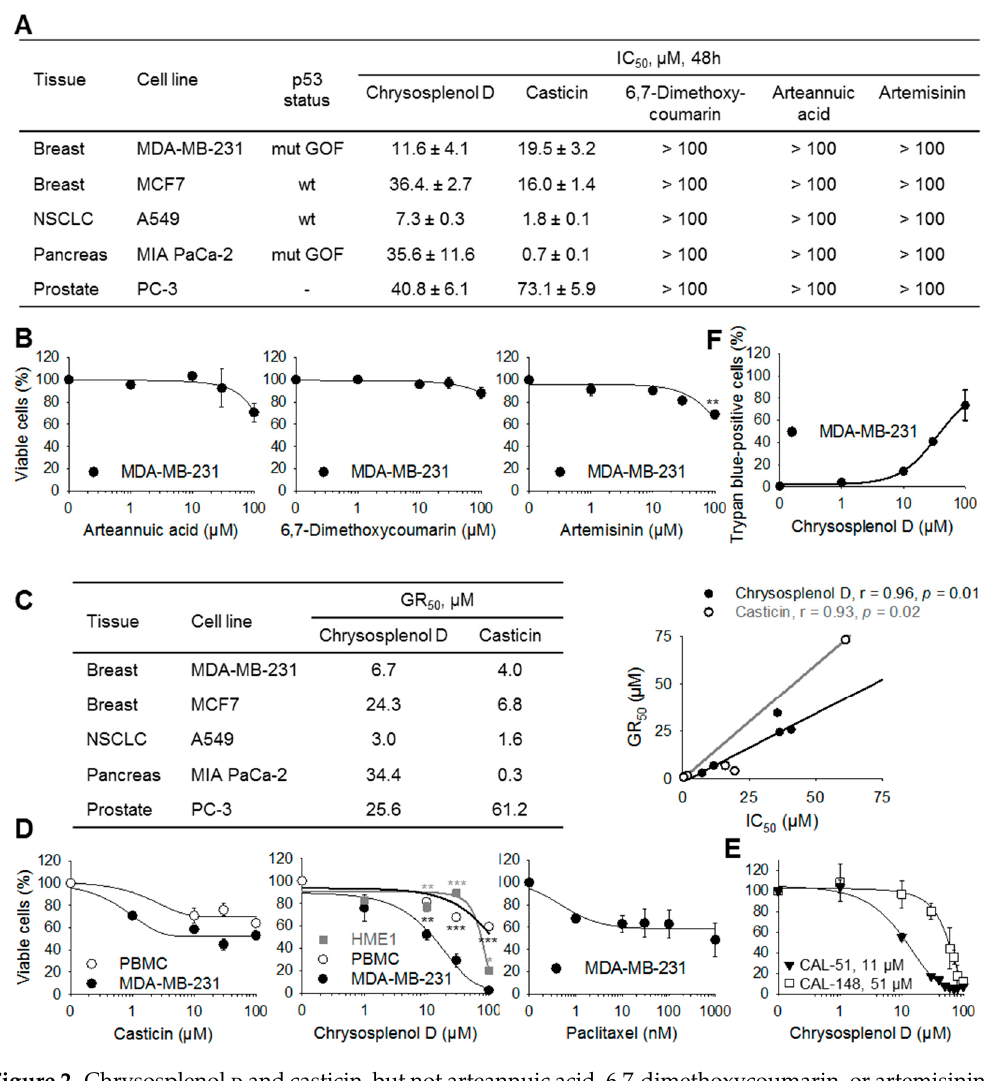
Figure 2. Chrysosplenol D and casticin, but not arteannuic acid, 6,7-dimethoxycoumarin, or artemisinin, inhibit selectively the viability of several cancer cell lines. Cells were treated with the various compounds for 48 h and analyzed by XTT ( A - E ). ( A ) NSCLC, non-small cell lung cancer; mut GOF, gain of function mutation. Apparent IC 50 values for casticin are shown. ( B ) Viability of MBA-MB-231 cells after treatment with arteannuic acid, 6,7-dimethoxycoumarin, and artemisinin (** p < 0.01 vs control). ( C ) Normalized growth rate inhibition values (GR 50 ) and Pearson ′ s correlation between GR 50 and IC 50 values. ( D ) Peripheral blood mononuclear cells (PBMC, open black circles) and HME1 normal breast epithelial cells (closed grey squares) are relatively resistant to chrysosplenol D . Paclitaxel—positive control, * p < 0.05, ** p < 0.01, *** p < 0.001 vs respective values of MDA-MB-231 cells. ( E ) Chrysosplenol D is toxic to the triple-negative breast cancer cell lines CAL-51 and CAL-148. Figures inside the graph are respective IC 50 values. ( F ) Toxicity of chrysosplenol D to MDA-MB-231 cells was analyzed by trypan-blue exclusion after 48 h. Data are mean ± standard error of the mean (SEM) of n = 3–5. 2.3. Chrysosplenol D and Casticin Inhibit the Cell Cycle Progression of MDA-MB-231 Cells in Vitro Chrysosplenol D induced cell cycle aberrations with accumulation of cells in the S-phase and partially in the G 2 /M-phase of the cell cycle, whereas the amount of cells in the G 1 -phase was concentration-dependently reduced (Figure 3A). This might indicate that cells in the G 2 /M-phase are particularly sensitive to chrysosplenol D and that they might undergo apoptotic cell death mimicking the DNA content of cells in the S-phase. Differently, and similar to paclitaxel, casticin induced a